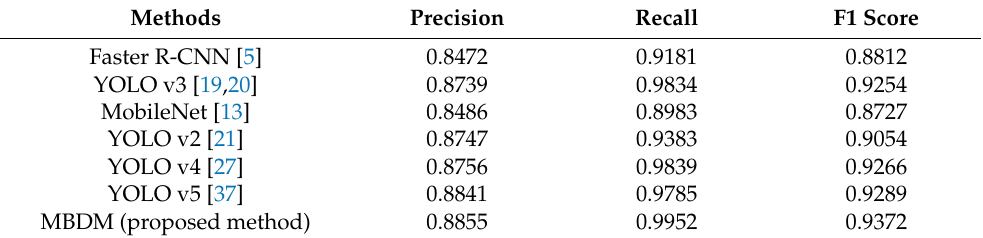
Table 10. Performance comparisons of the proposed method and the state-of-the-art methods with EUR.